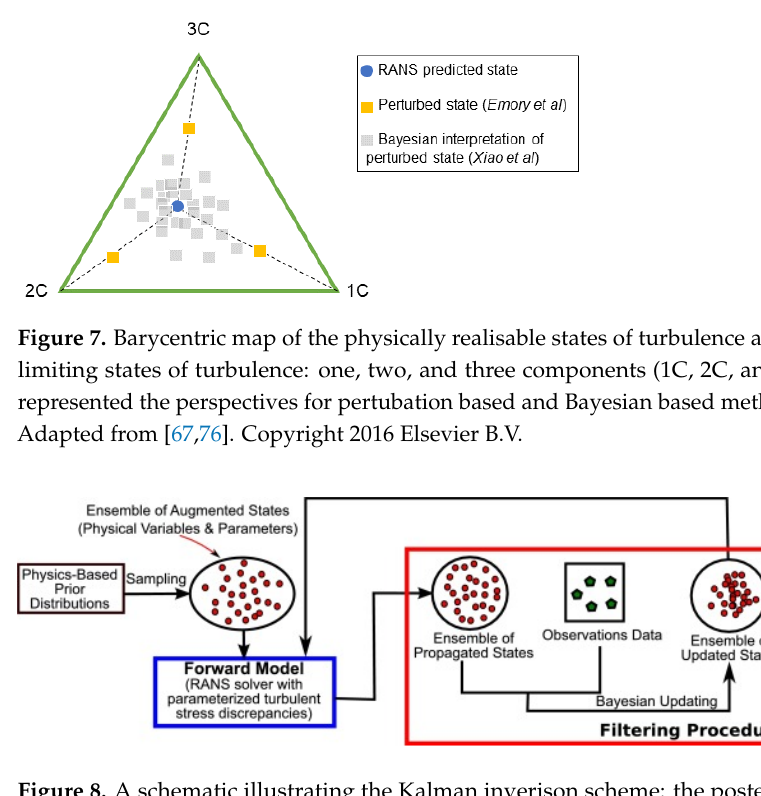
Figure 8. A schematic illustrating the Kalman inverison scheme: the posterior distribution for the uncertain parameters in RANS is adjusted to reconcile the ensemble of propagated states as closely as possible with the observations. Adapted from [72]. Copyright 2016 Elsevier